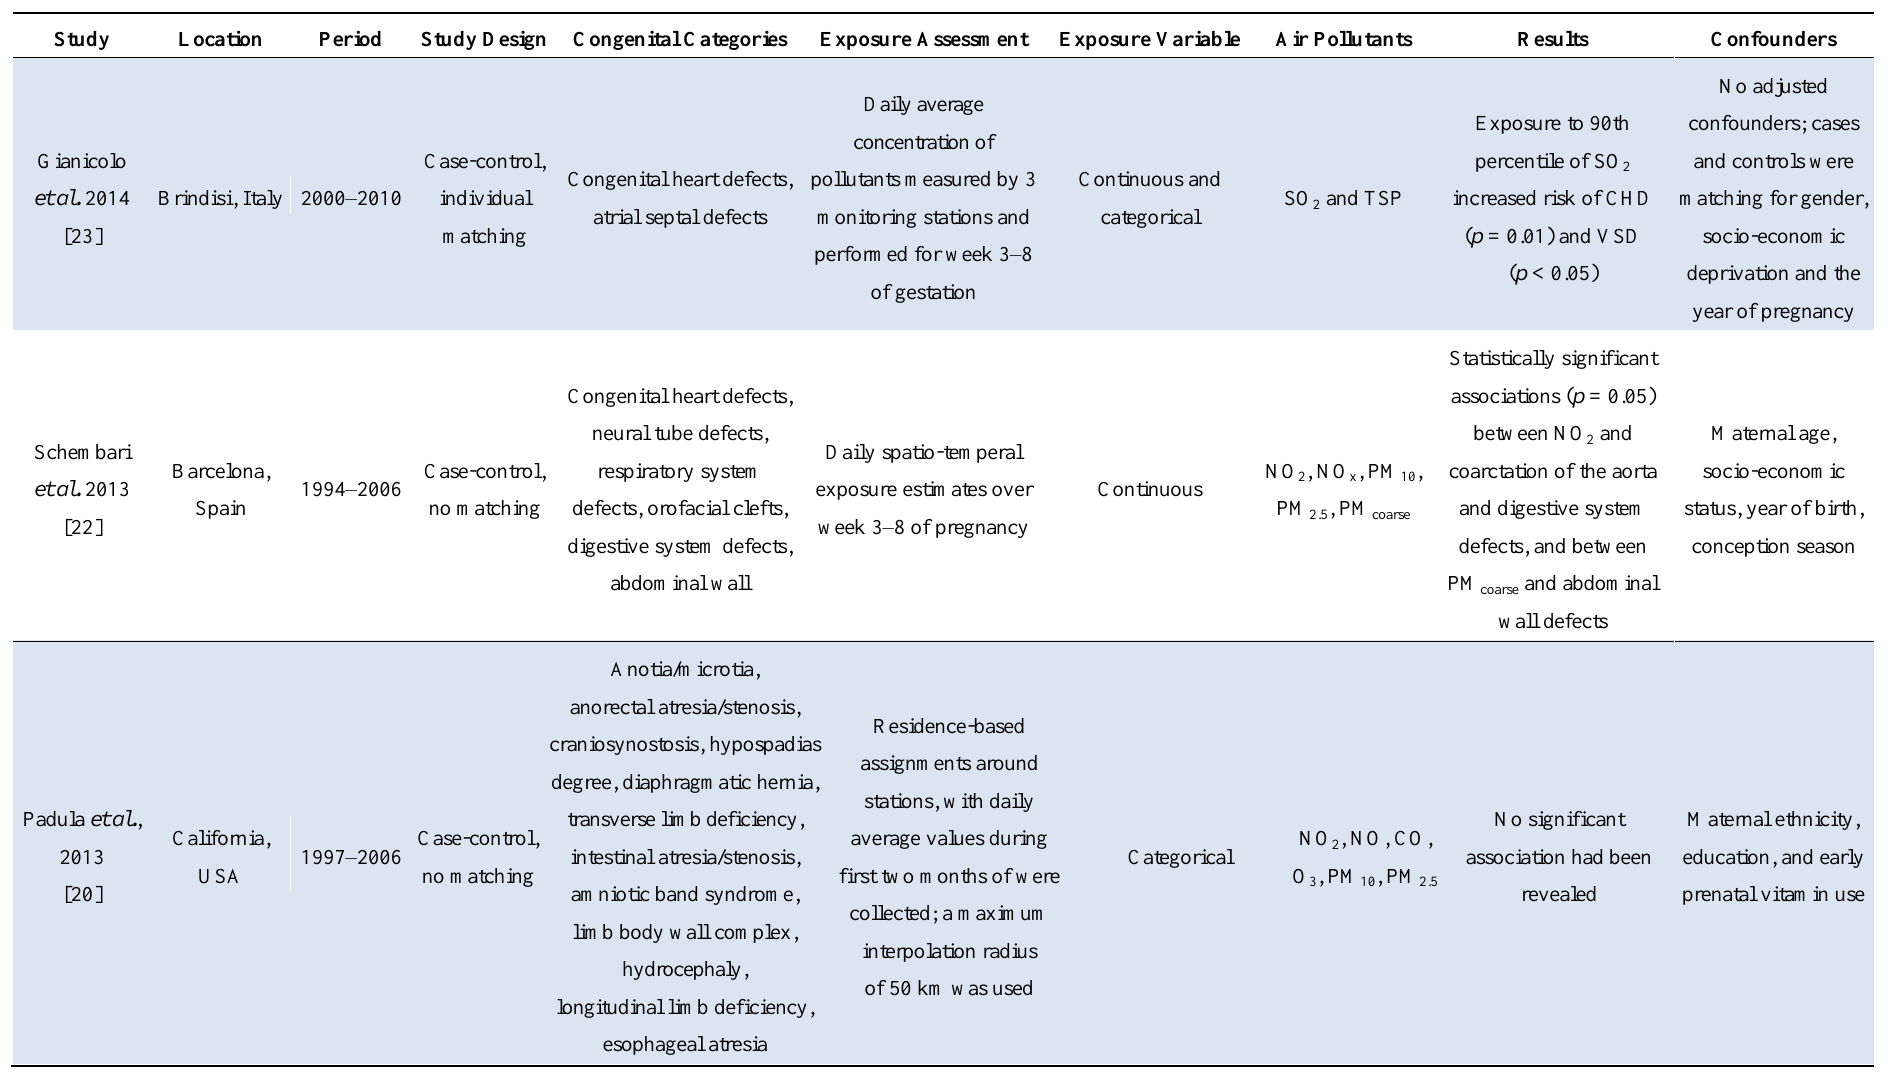
Table 1. Overview of studies included in the systematic